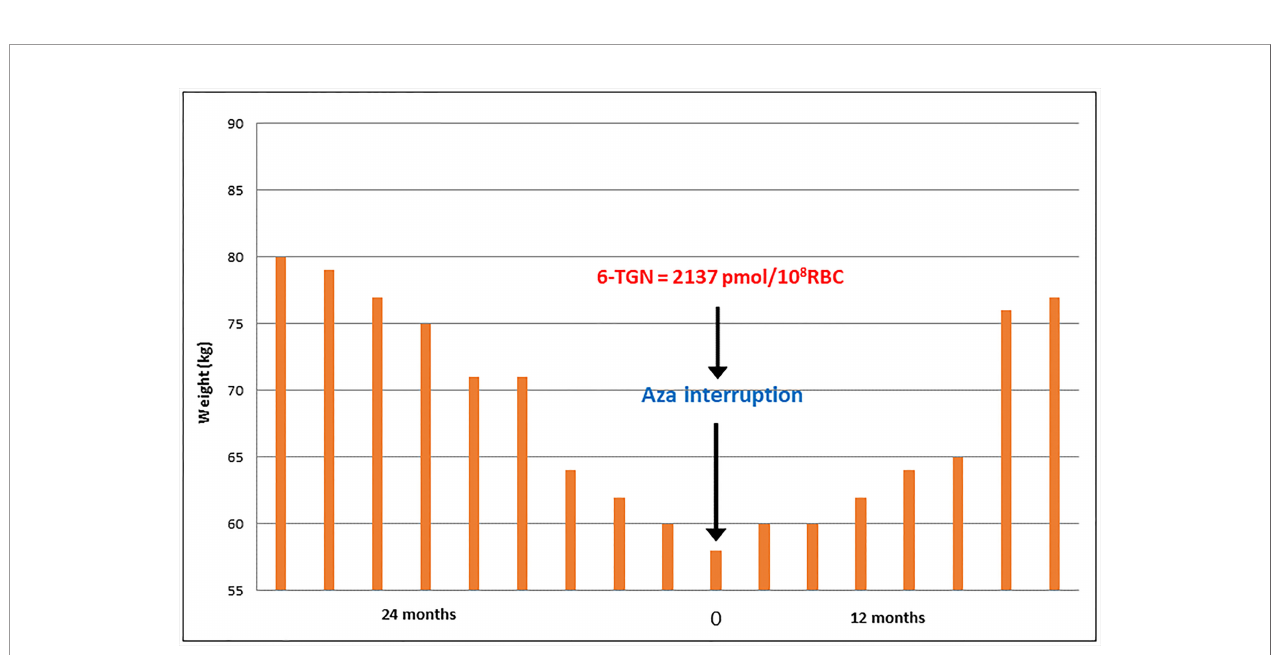
FIGURE 1 | Case 1: Three episodes of pancreatitis related to AZA intake, during an 18-month period. AP, acute pancreatitis.